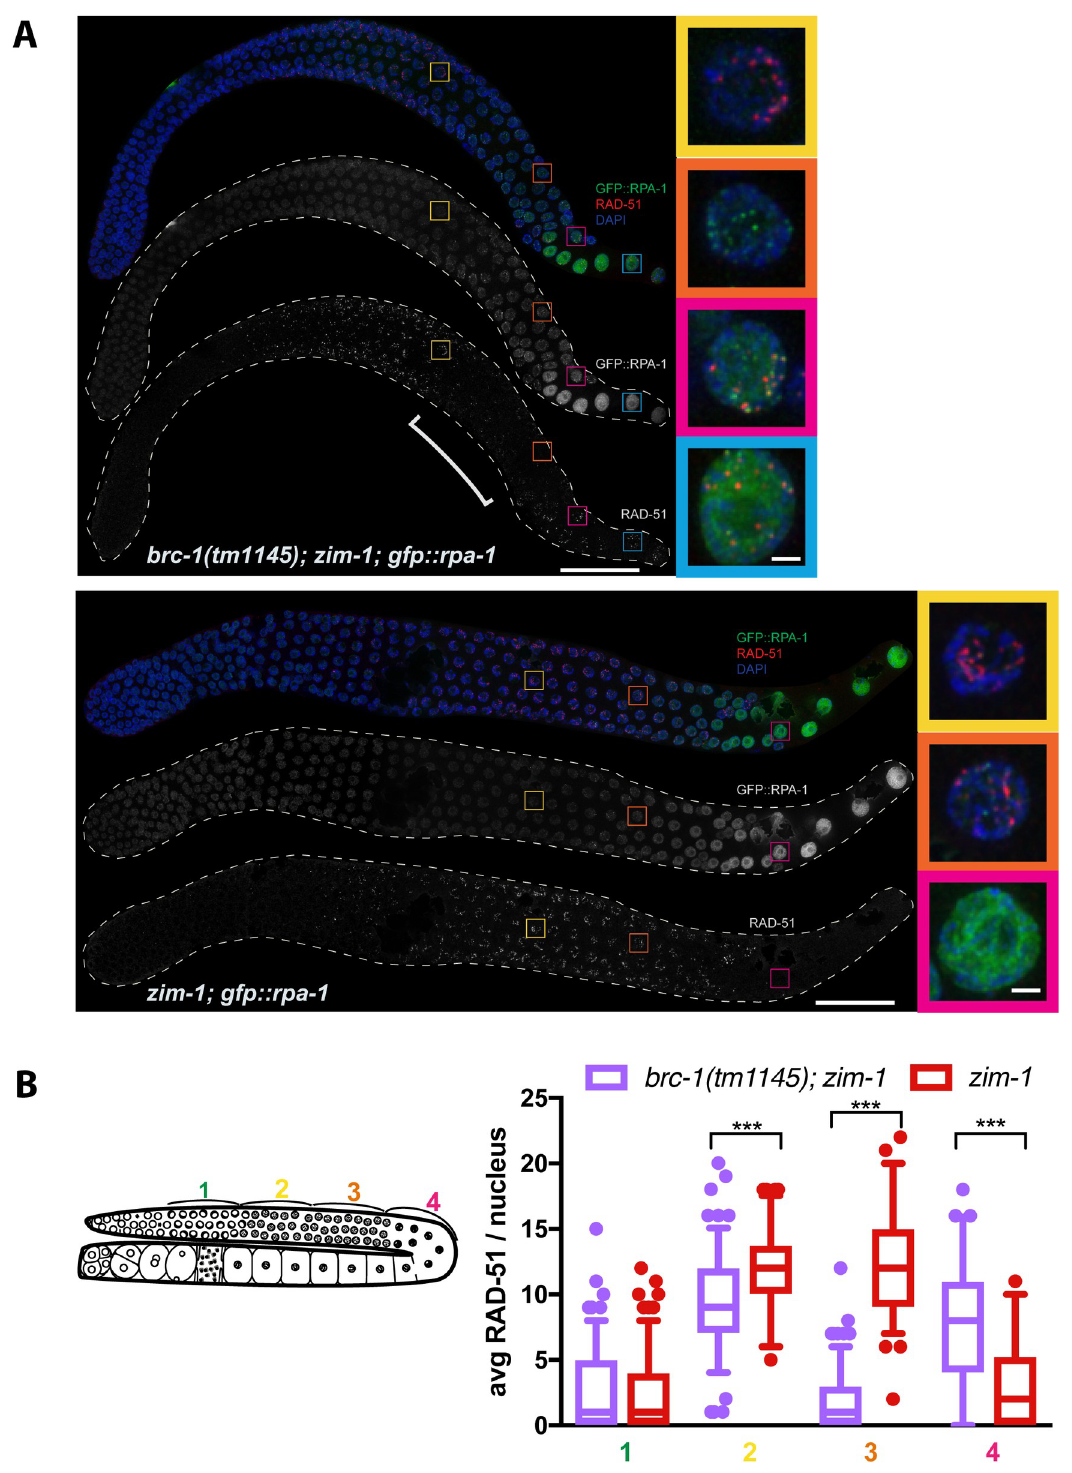
Fig 6. Inactivation of BRC-1-BRD-1 alters the pattern of RAD-51 foci in the zim-1 mutant. A) Dissected germ lines from brc-1 (tm1145); zim-1; gfp :: rpa-1 and zim-1; gfp :: rpa-1 worms stained with anti-RAD-51 (red), counterstained with DAPI (blue) imagined for GFP::RPA-1 fluorescence (green). Scale bar = 20 μ m. Insets show selected nuclei from different regions of the germ line; bracket indicates RAD-51 “dark zone”. Images are projections through half of the gonad. A minimum of 3 germ lines were examined for each genotype. Scale bar = 1 μ m. B) Schematic of germ line indicating zones for analysis of RAD-51 foci. Box whisker plots